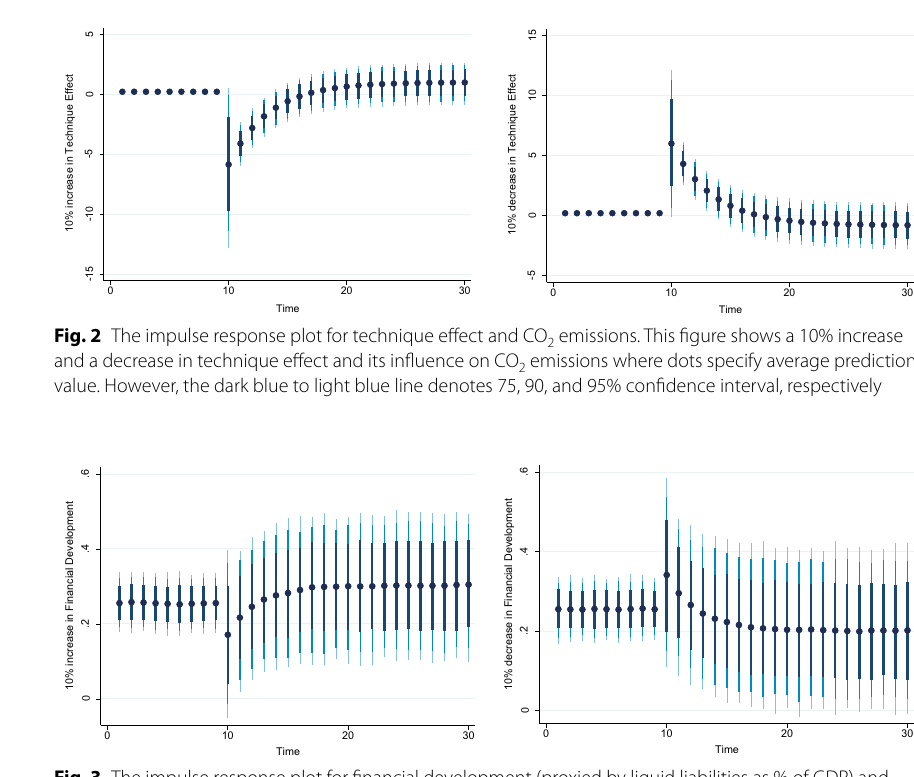
Fig. 3 The impulse response plot for financial development (proxied by liquid liabilities as % of GDP) and CO 2 emissions. This figure shows a 10% increase and a decrease in financial development and its influence on CO 2 emissions where dots specify average prediction value. However, the dark blue to light blue line denotes 75, 90, and 95% confidence interval, respectively